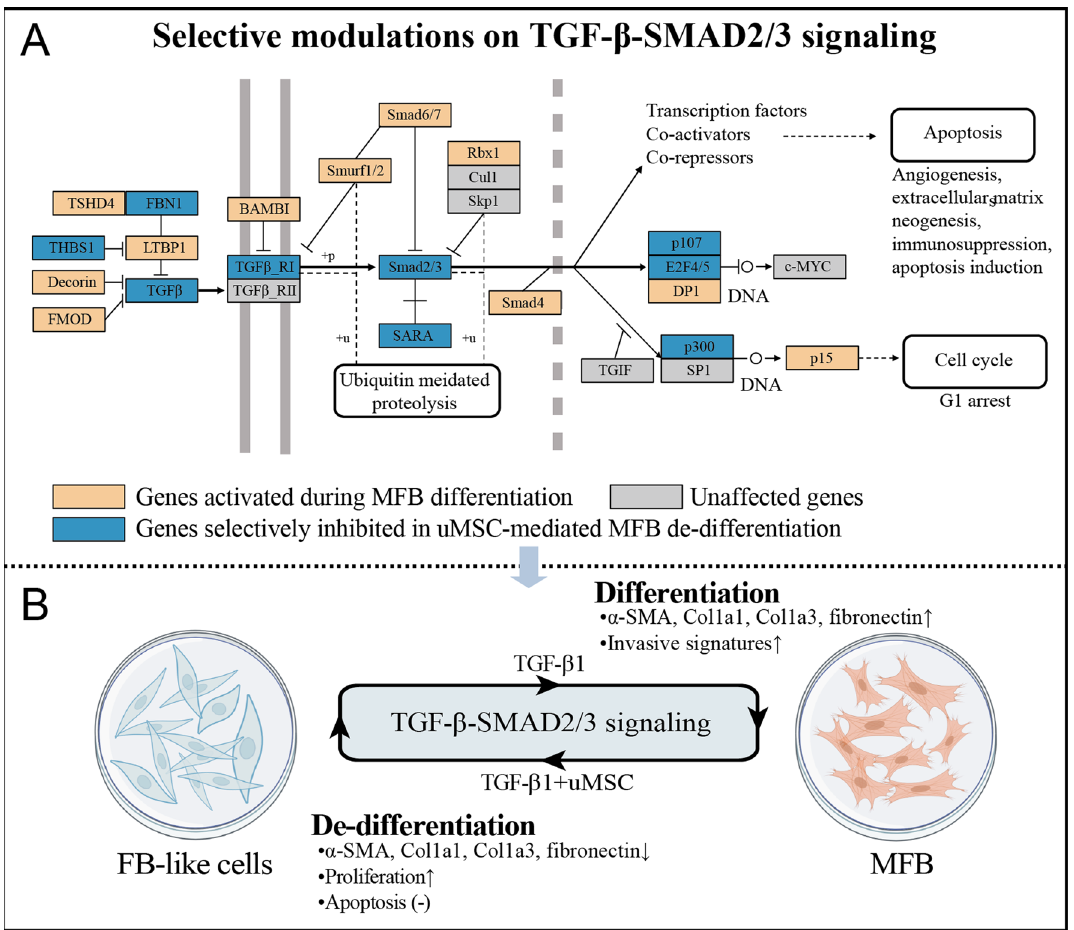
Fig. 8 Selective modulations on the TGF-β-SMAD2/3 signaling. A Regulations of transcripts in TGF-β-SMAD2/3 signaling according to the KEGG database. B uMSC reversibly de-differentiate TGF-β1-induced MFB into a group of FB-like cells by modulating the TGF-β-SMAD2/3